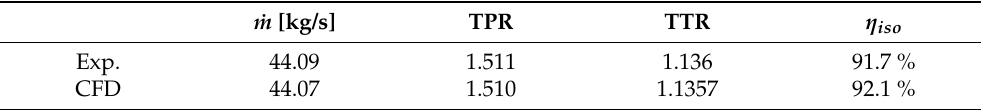
Table 2. NASA/GEAE R4 fixed-nozzle take-off operation. Comparison of CFD result and wind tunnel measurements.